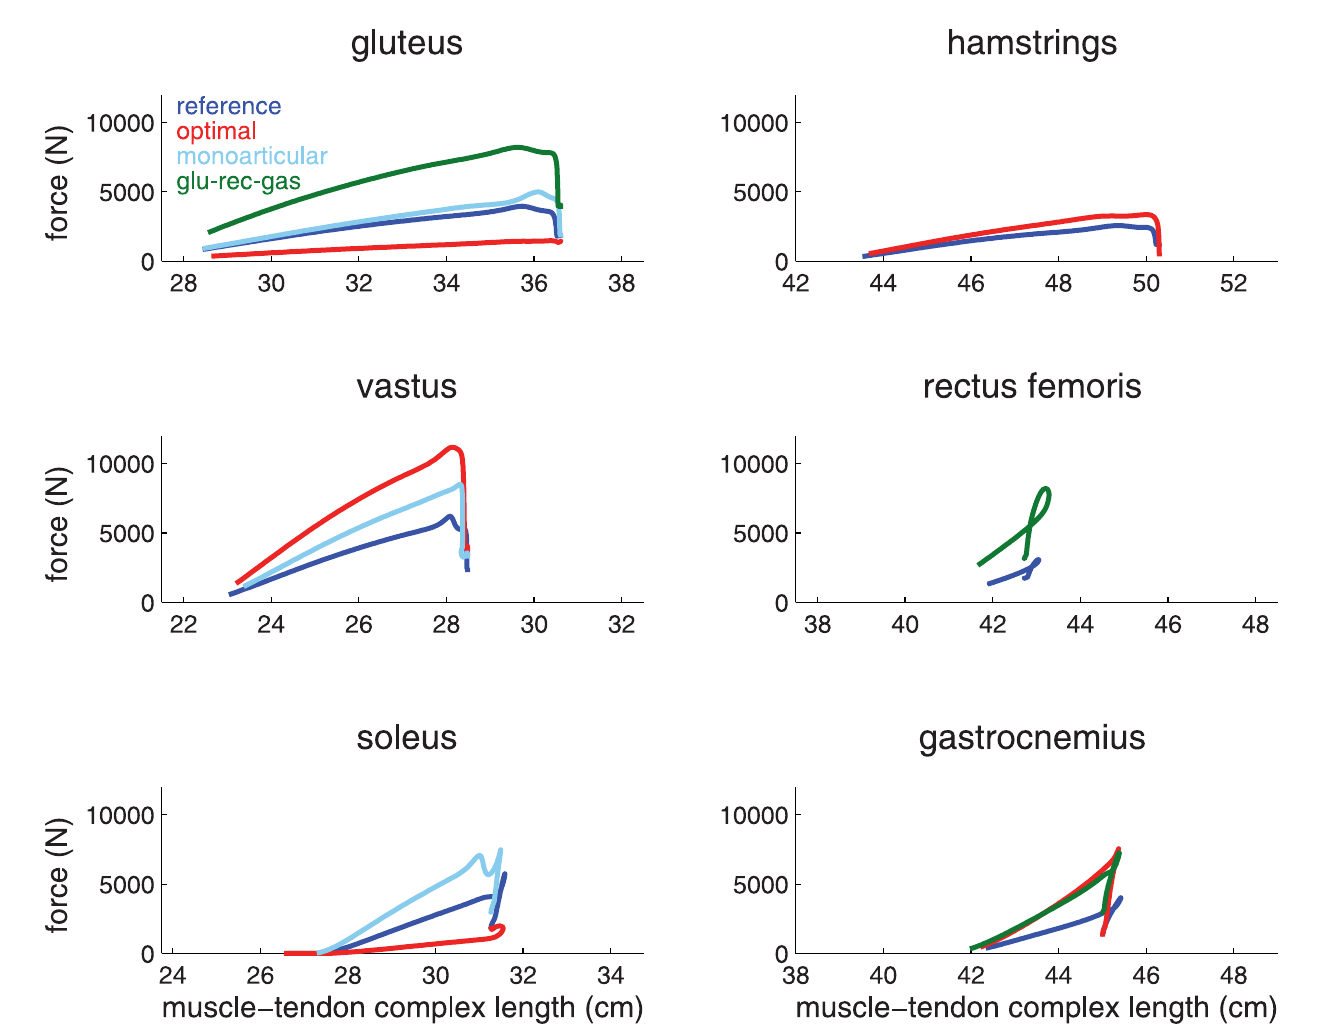
Fig 3. Muscle work for monoarticular model and reference model. The force as a function of muscle-tendon complex length is plotted for each of the muscles in the monoarticular model (dashed lines) and reference model (solid lines). Total muscle volume for both models are held constant. The monoarticular muscles are presented in the left column. glu-rec-gas = gluteus-rectus femoris-gastrocnemius model.